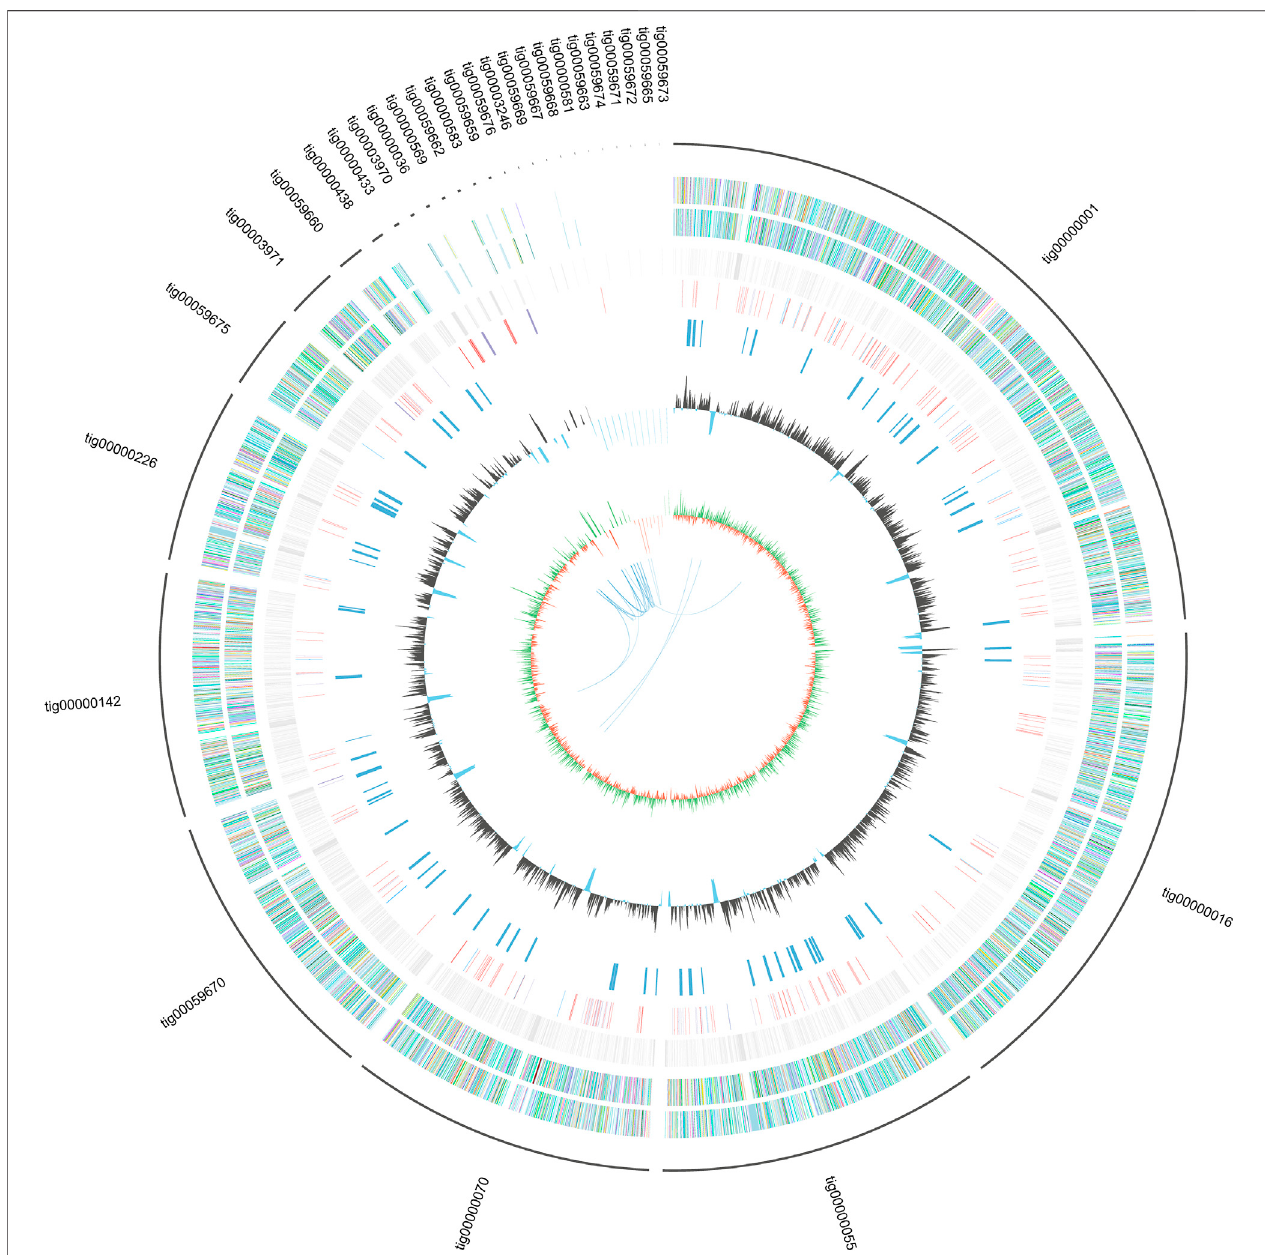
FIGURE1| Generalgenomefeaturesofmarinestrain Aspergillusniger L14(Fromtheinsideout:In-paralogpairs; GCskew,thegreenpartrepresent positivevalue while the orange part represent negative value; G + C%; SMs gene clusters; ncRNA; repeat; minus strand coding sequence (CDS) annotation; plus strand CDS annotation;